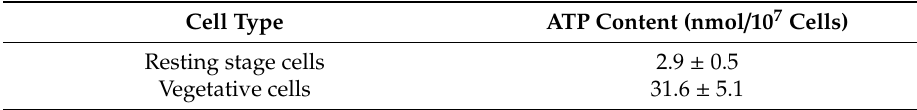
Table 1. Measurements of intracellular content of ATP in the vegetative cells and resting stage cells of A. anophagefferens strain CCMP1984. Standard deviation (± SD) of the data from three independent experiments. For each experiment, three technical replicates were performed.